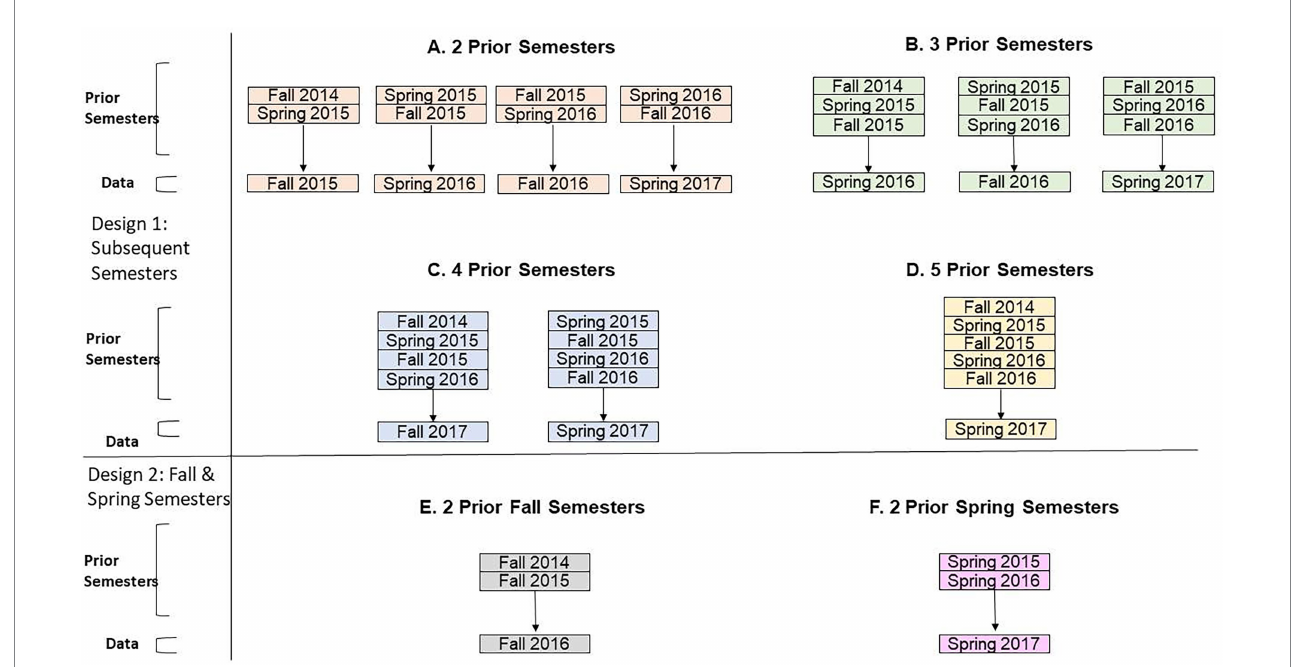
FIGURE 2 Empirical Bayesian methodology using aggregated semesters of prior data. The “Prior Semesters” are used to specify the mean and precision for the distribution of the model covariates. The “Data” terms are the single semesters of course data that the logistic regression models were run